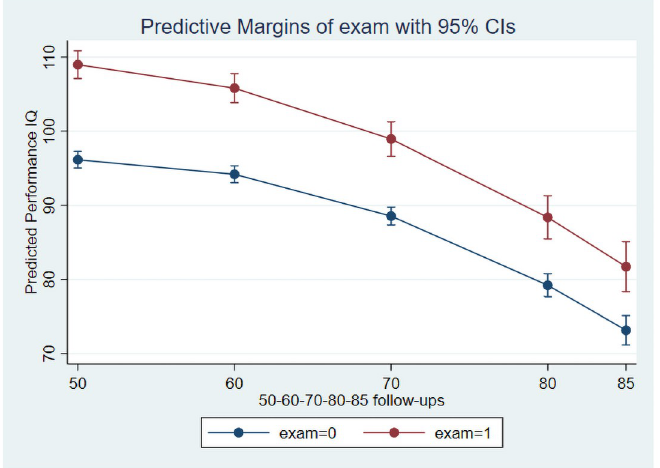
Fig 2. Decline of Performance IQ stratified on education over a 35-year follow up.